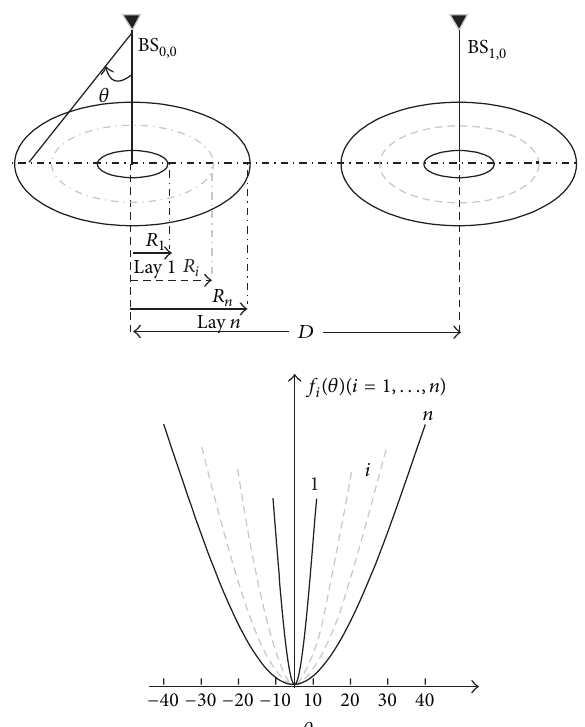
Figure 1: Adaptive multibeam antenna hierarchical cellular struc-